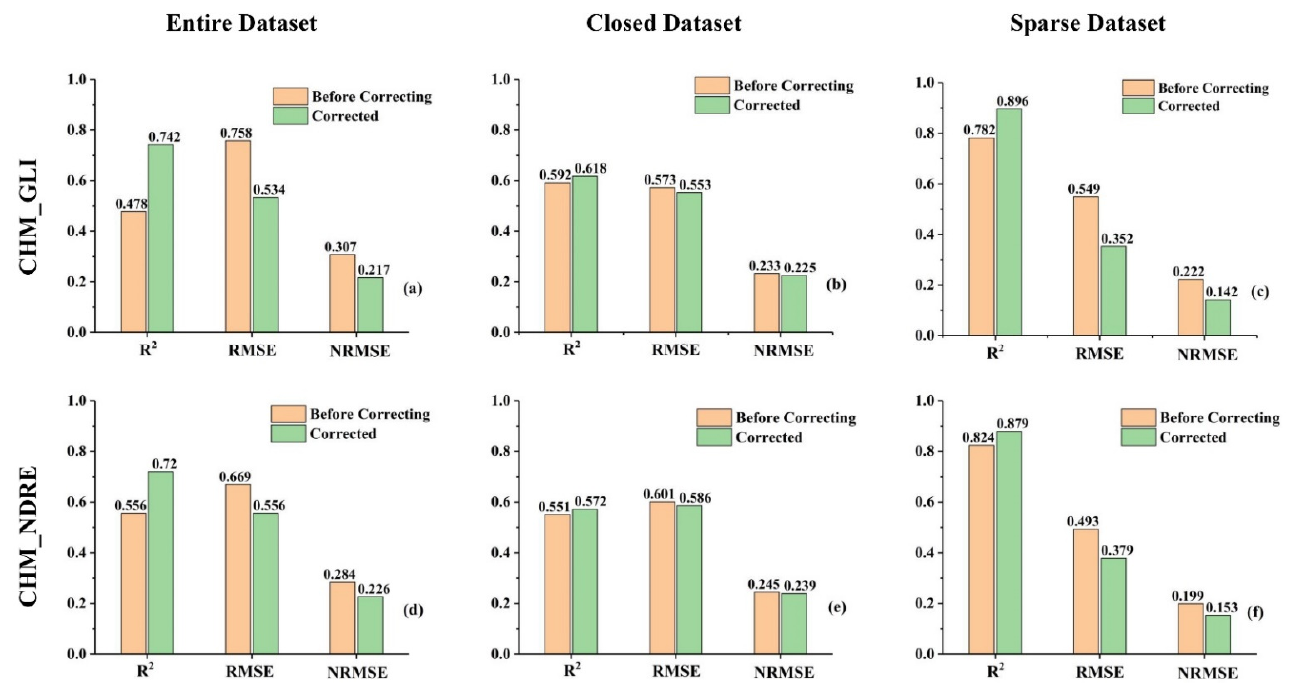
Figure 7. Estimation performances of the LAI estimation model in three datasets before and after correction with CC. ( a – f ) shown the estimation performances of CHM_GLI and CHM_NDRE on entire, closed and sparse dataset respectively.